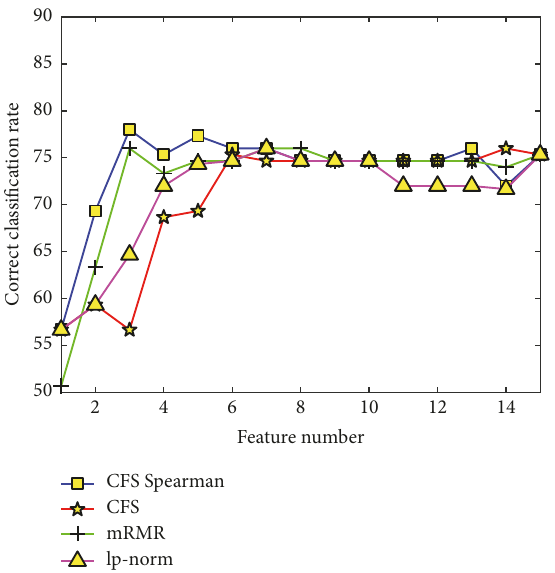
Figure 3: Correct classification rate using video features by different methods.